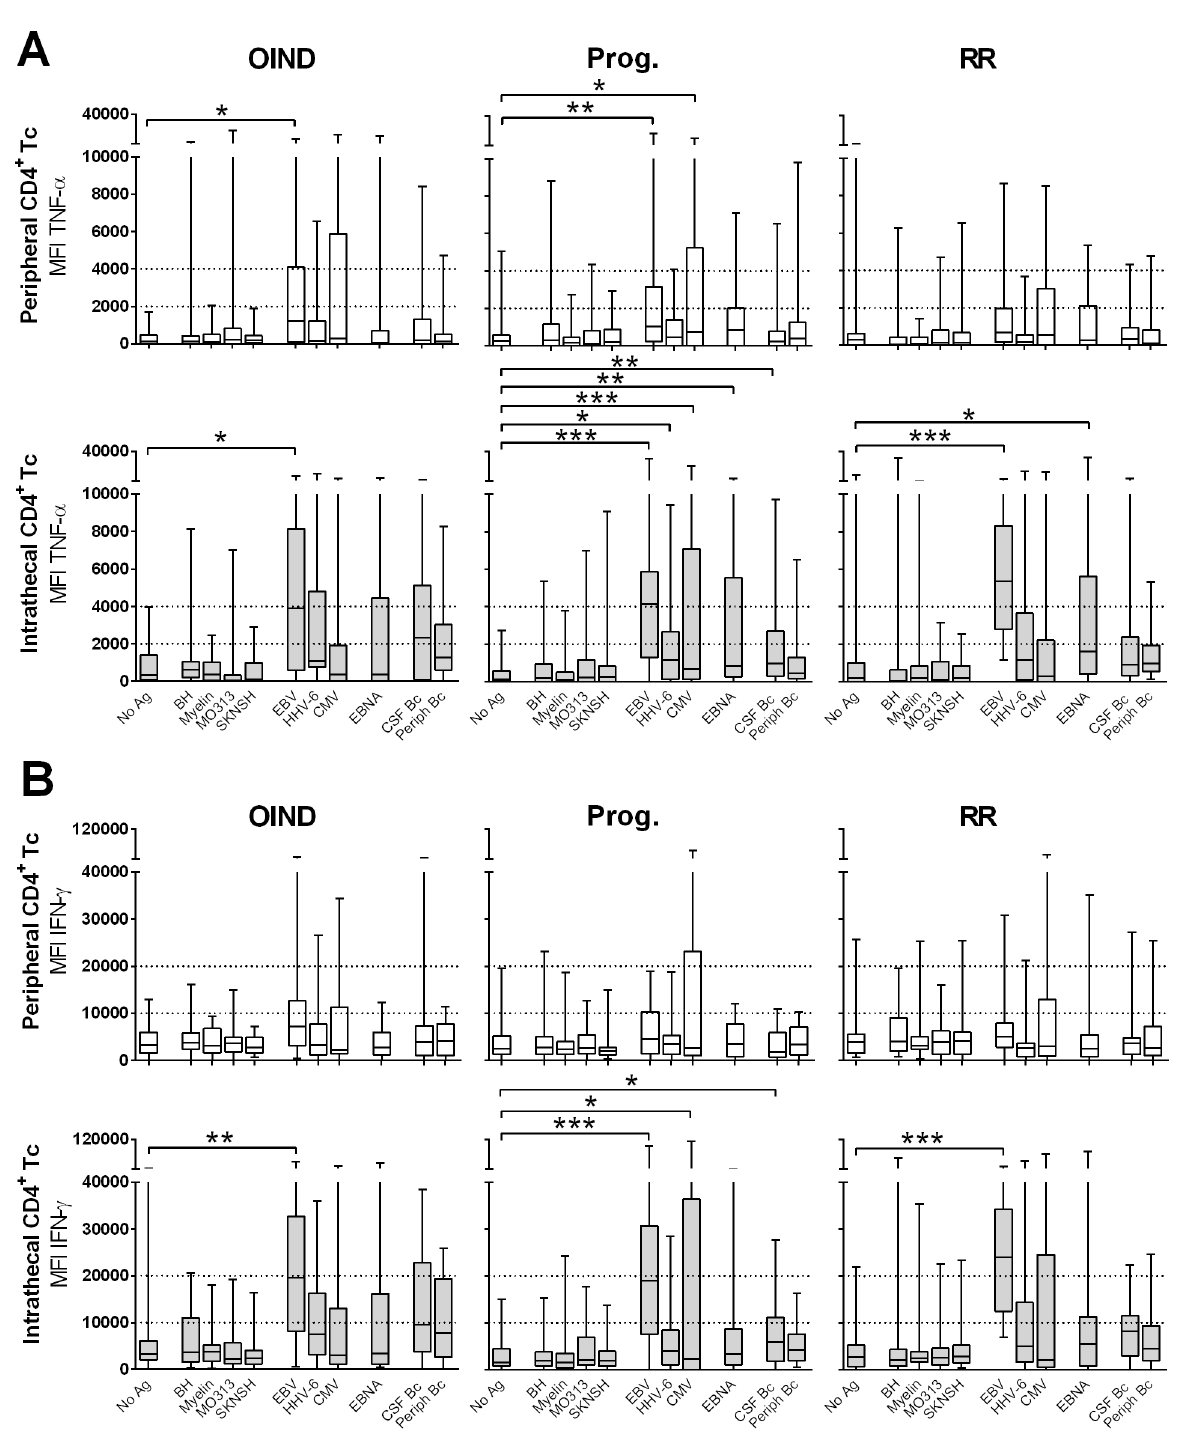
Figure 4. MFIs of peripheral and intrathecal CD4 + T cells. MFIs of TNF- a - ( A ) and IFN- c -producing ( B ) peripheral (upper panels) and intrathecal (lower panels) CD4 + T cells are shown for OIND, progressive (Prog.) and relapsing-remitting (RR) patients in response to all candidate Ag’s. *0.01 , p , 0.05, **0.001 , p , 0.01, ***p , 0.001 .